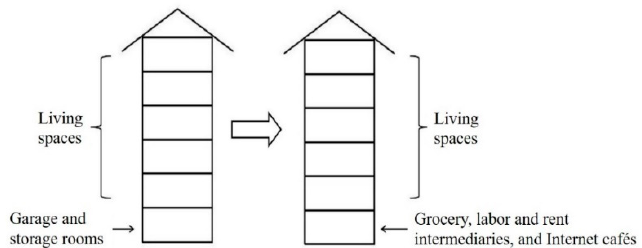
Figure 6. Renovation of the residential building space of Qunyi Community.